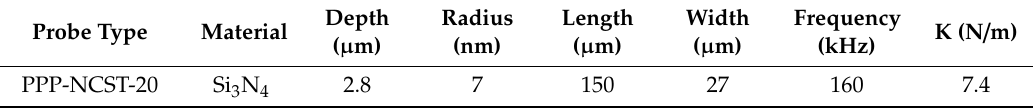
Table 3. Parameters of the AFM